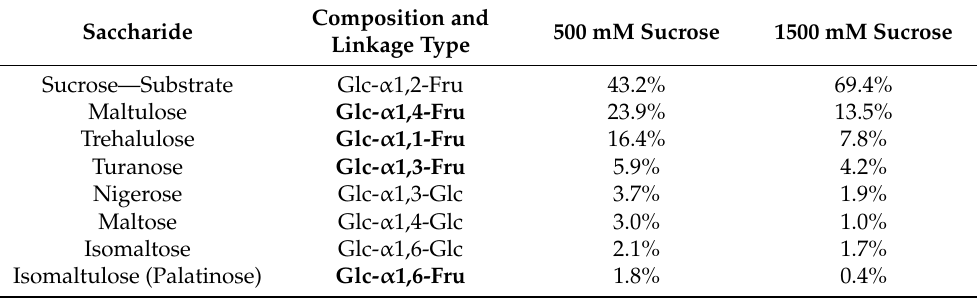
Table 1. Disaccharide proportions in transglycosylation reactions with 500 mM or 1500 mM sucrose by the Ba AG2. Sucrose isomers are shown in bold.